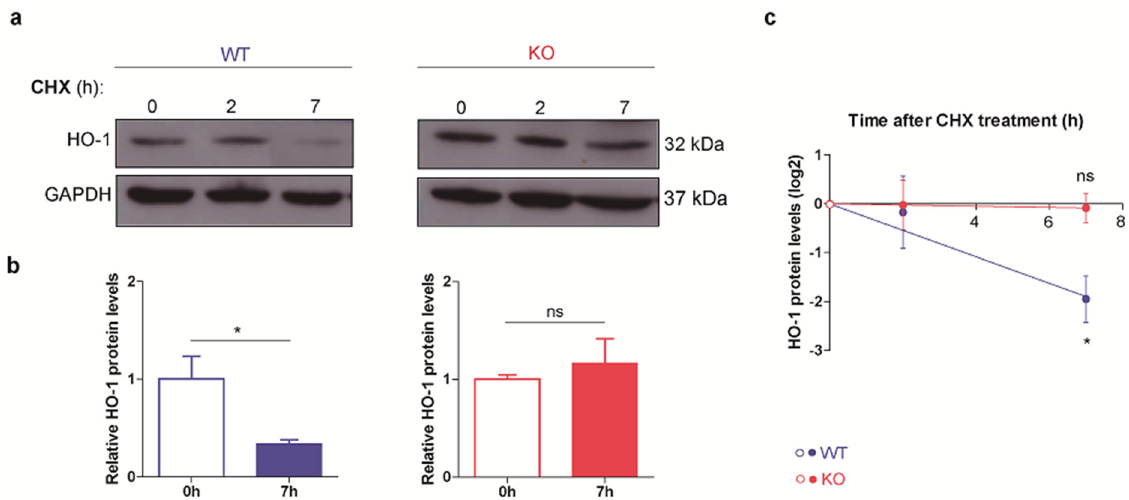
Figure 3. HO-1 half- life is longer in p53 KO embryonic stem (ES) cells. WT and p53 KO ES cells were treated with 10 µ M cycloheximide (CHX) during 2 and 7 h. HO-1 levels were analyzed by Western blot. ( a ) Representative blots of HO-1 in WT and p53 KO ES cells. GAPDH was used as loading control. ( b ) HO-1/GAPDH band densitometry of vehicle control (DMSO: 0 h) and CHX treatment (7 h). Bars represent the mean ± SEM of three independent experiments. ( c ) Time-dependent HO-1 expression plot. Dots represent the mean ± SEM of three experiments. Asterisks indicate significant differences compared to the control (*, p < 0.05).